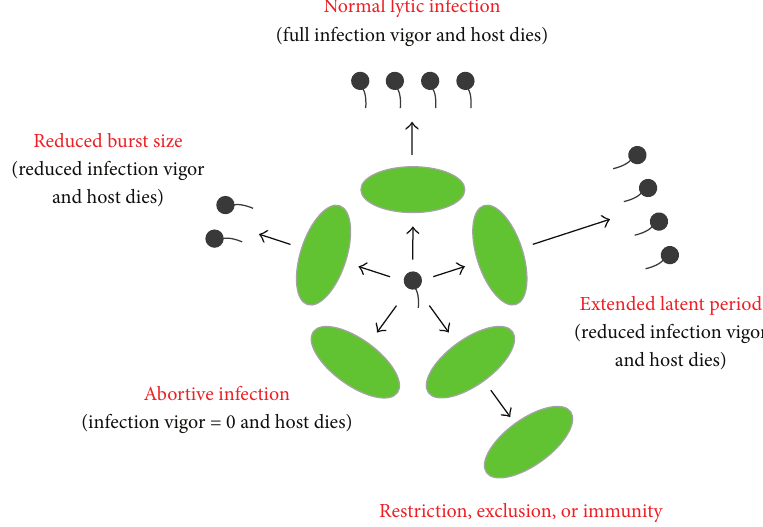
Figure 13: Ecological as well as physiological perspective on bacterial resistance to phages as seen following phage adsorption. Specifically, there exist gradations in bacterial interference with phage productivity ranging from (i) no interference (“normal lytic infection”) to (ii) partial blocks on phage productivity and/or extension of the phage infection cycle that can slow down phage population growth (“reduced infection vigor” [17] as seen with “reduced burst size” or “extended latent period”) to (iii) bacterial self-sacrifice for the sake of phage elimination (“abortive infection”; see also [225]) to (iv) bacteria simply inactivating infecting phages but without loss of bacterial viability (“restriction, exclusion, or immunity”; hosts in any case are shown as green ovals). These various mechanisms are reviewed by Hyman and Abedon [17] and also Labrie et al. [164]. Not shown, bacteria can also block phage infection by resisting phage attachment following phage encounter, though generally this does not result in phage metabolism in either a physiological or pharmacological sense. For comparison of mechanisms of bacterial resistance to phages to the immunity displayed especially by animals against pathogens, see Abedon [227]. Note also that analogies exist between mechanisms of bacterial resistance to phages and mechanisms of bacterial resistance to antibiotics. These include as mediated by compound destruction or avoidance of interaction through changes in target structures, though notably absent is a phage-resistance equivalent to “efflux off the antibiotic from the cell” (p. 1451)